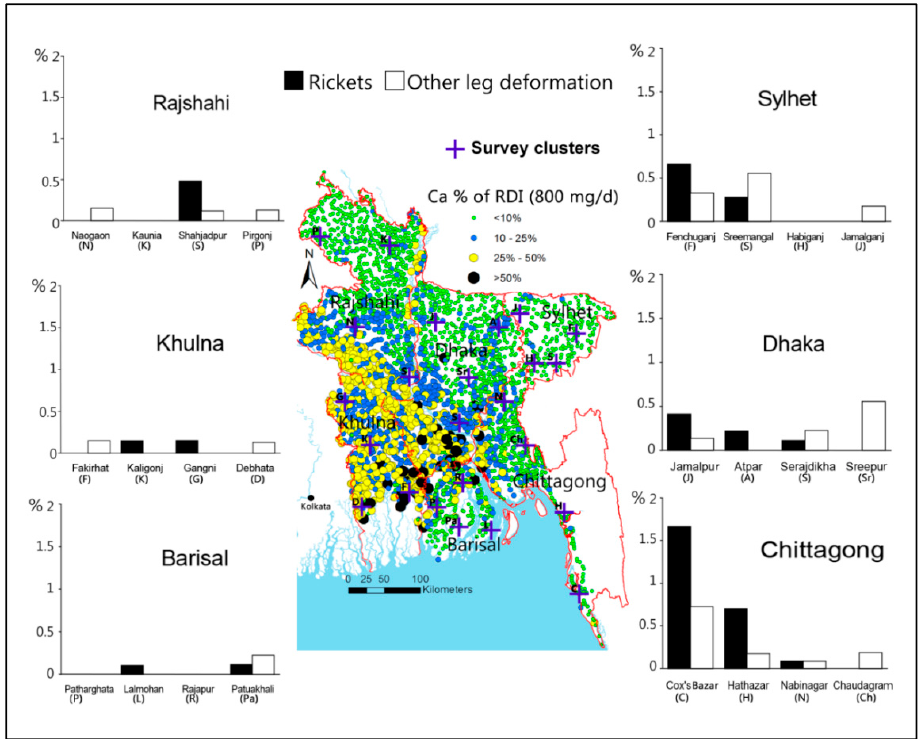
Figure 9. Possible spatial association between prevalence of rickets and other leg deformities and Ca concentration in tubewells in Bangladesh. Water composition data from [22], and data on rickets and other leg deformities are based on [64].